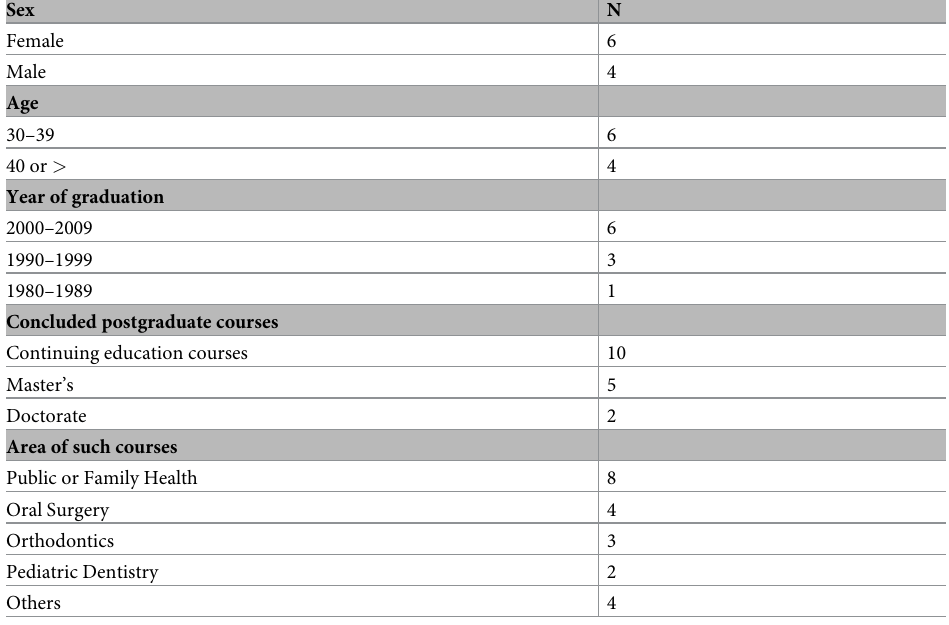
Table 1. Sociodemographic characteristics of the dental surgeons from Family Health Care Units, Piracicaba, SP,